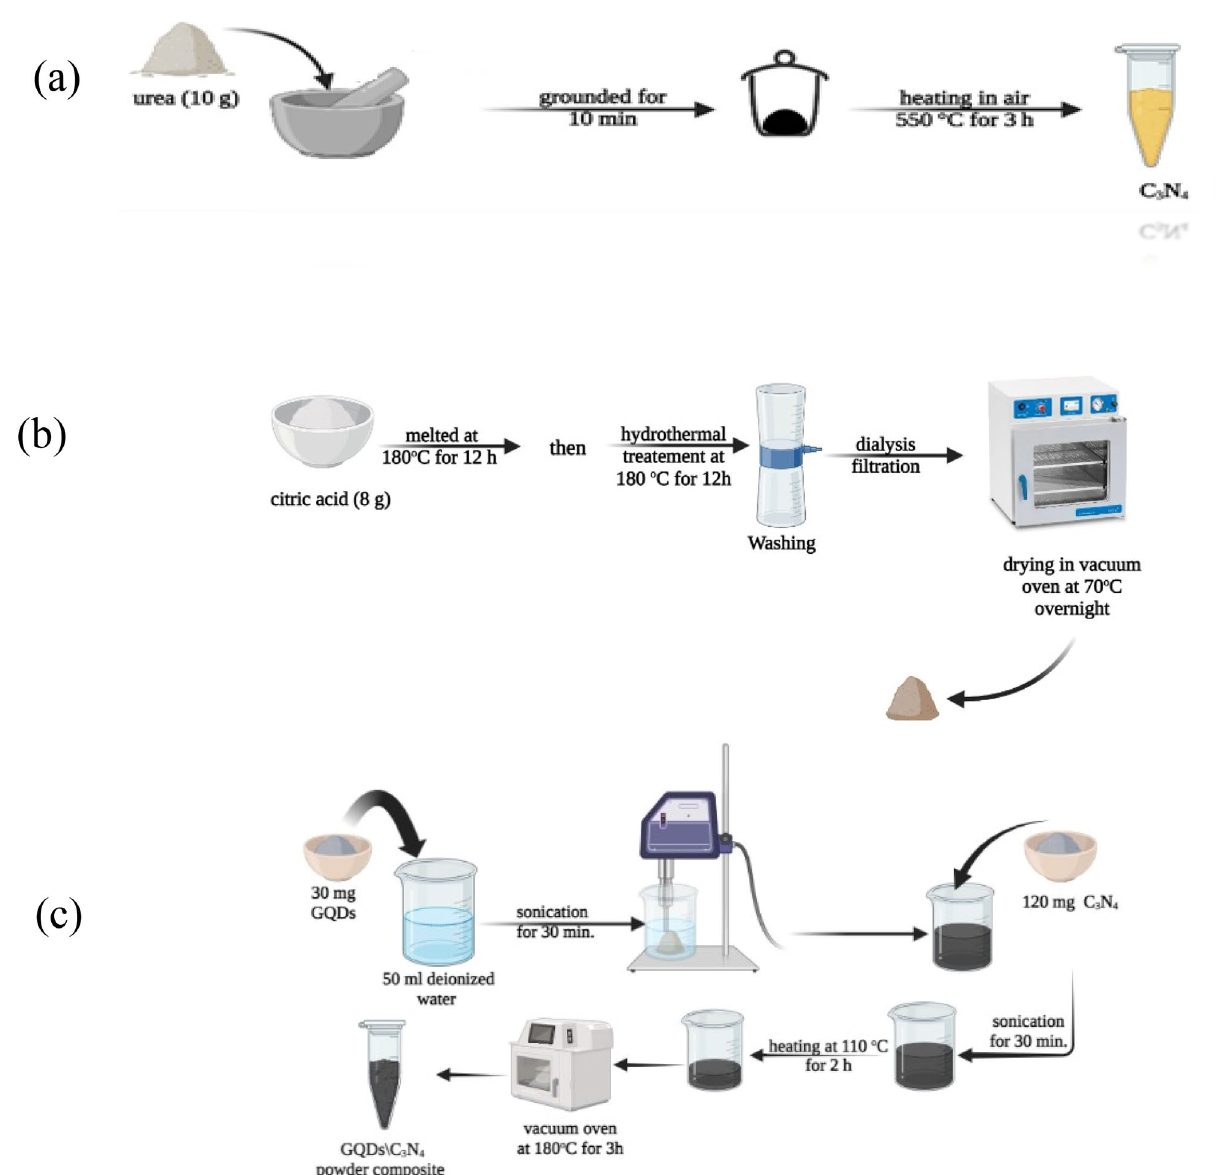
Figure 1. Schematic representations of materials synthesizing procedures ( a ) g C3N4, ( b ) GQDs, and ( c ) GQDs/g-C3N4